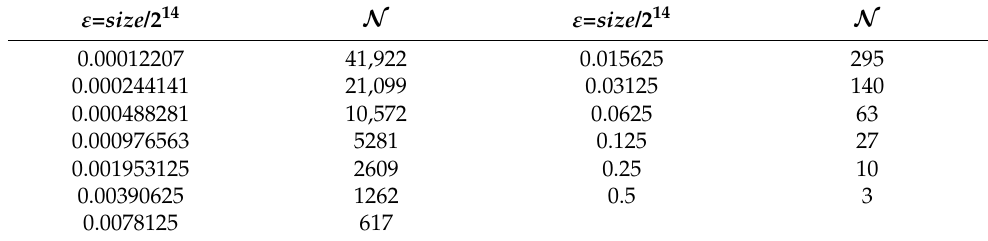
Table 3. Values of ε and N for each n .